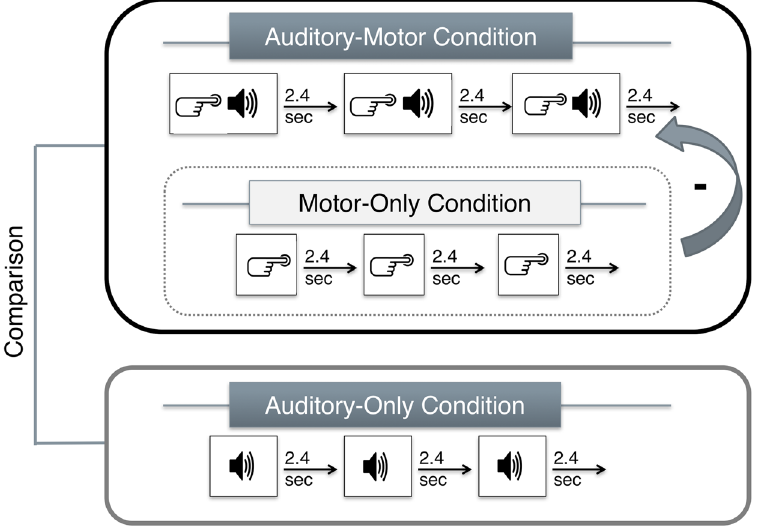
Figure 1. Schematic illustration of the three experimental blocks. A fixation cross was presented in the middle of a computer screen. Participants were instructed to change the index finger after 50 trials to ensure that the motor activation pattern was similar across participants during the AMC and AOC conditions, following indications on the screen (to avoid counting or cognitive demands associated with finger memorization). Change of index fingers was counterbalanced across participants. Notes: AMC = auditory-motor